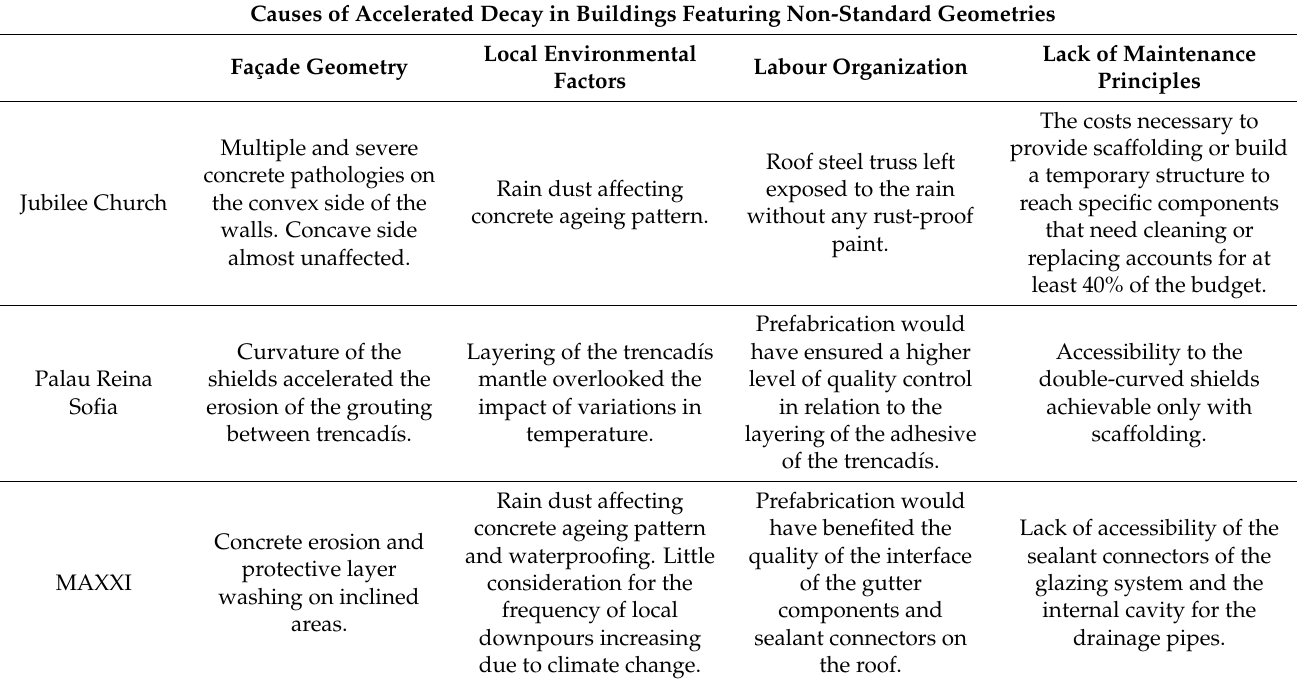
Table 2. Comparison between potential causes of premature decay in non-standard